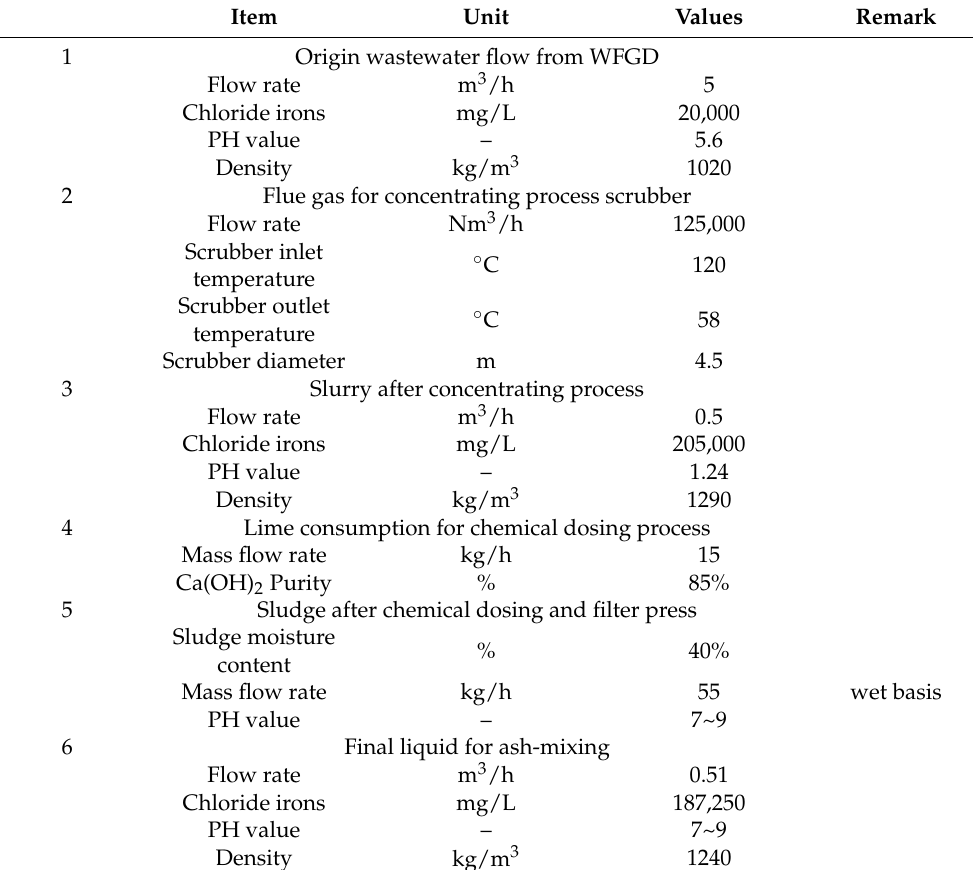
Table 6. Key parameter of one 600 MW demonstration